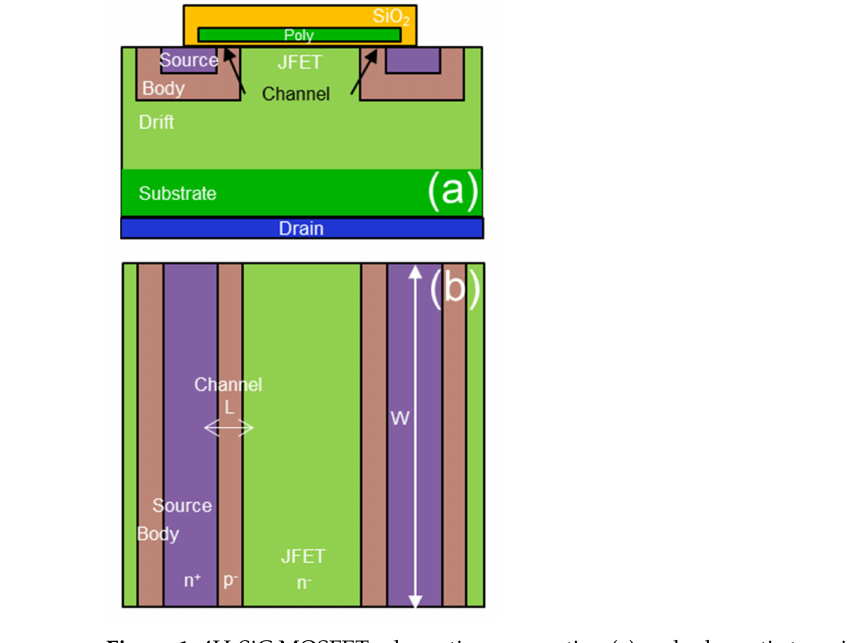
Figure 1. 4H-SiC MOSFET schematic cross-section ( a ) and schematic top view ( b ).